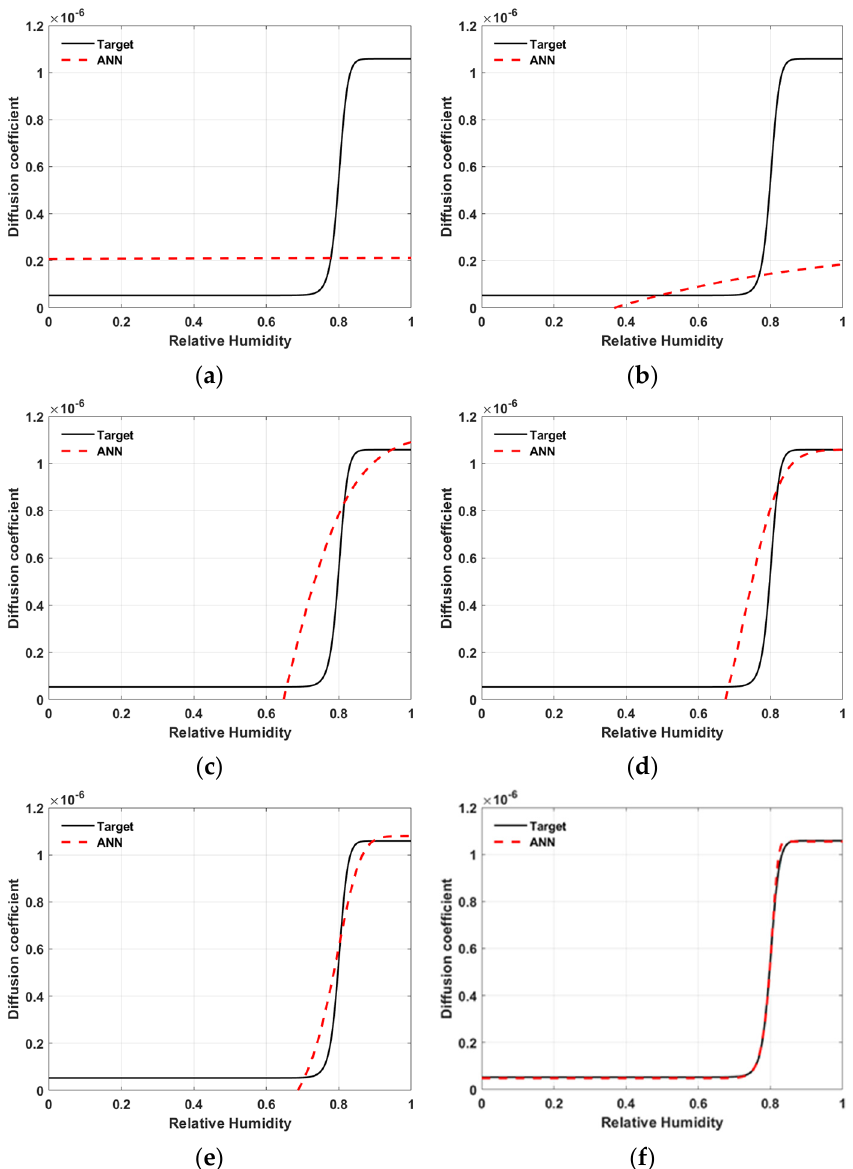
Figure 11. An example of adaptive process with iteration in optimization (Network N1, Material M2, and observation period of 180 days)—the number of the iterations: ( a ) 0, ( b ) 20, ( c ) 100, ( d ) 150, ( e ) 200, ( f ) 300.